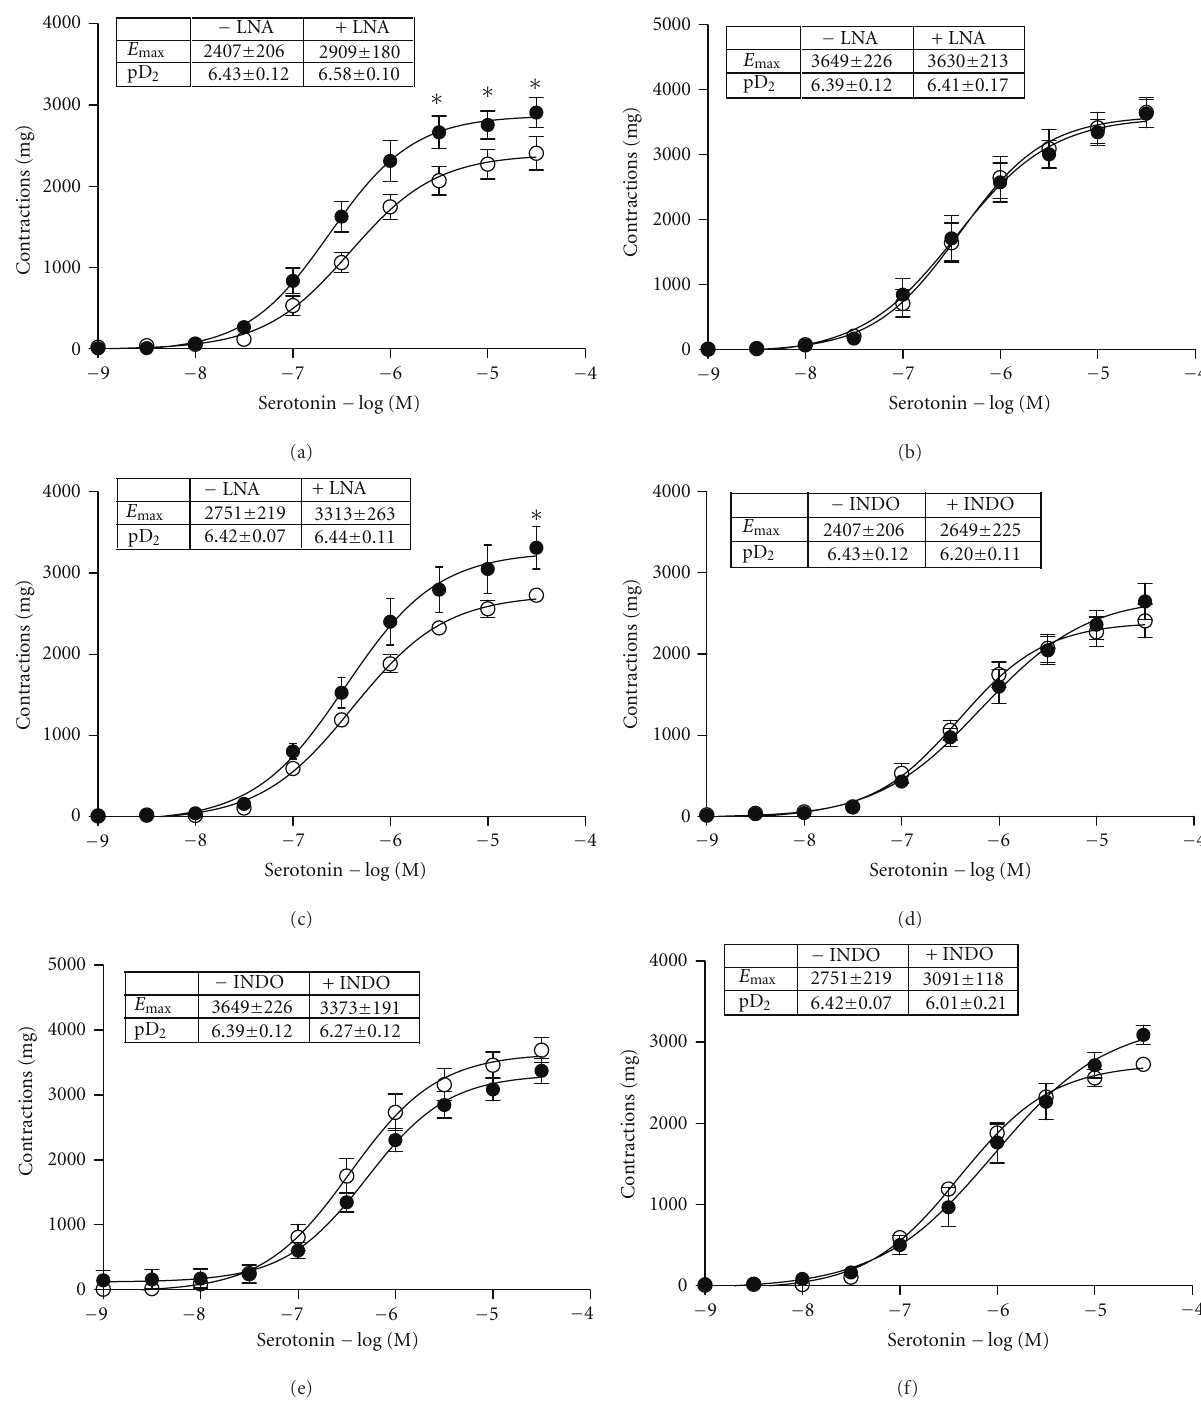
Figure 4: The e ff ects of inhibition of nitric oxide synthesis by LNA and cyclooxygenase inhibition by INDO on the contractile responses to serotonin in isolated rabbit carotid artery. Figures from control group (a, d), cholesterol group (b, e), and cholesterol + fluvastatin group (c, f). Ring presentations of carotid arteries from − LNA or − INDO ( (cid:3) ) ( n = 5) and +LNA or +INDO ( (cid:2) ) ( n = 5) in the groups. Values are expressed as means ± S.E.M. ∗ P < 0 . 05 compared with − LNA and +LNA or − INDO and +INDO in the groups, Wilcoxon paired signed ranks